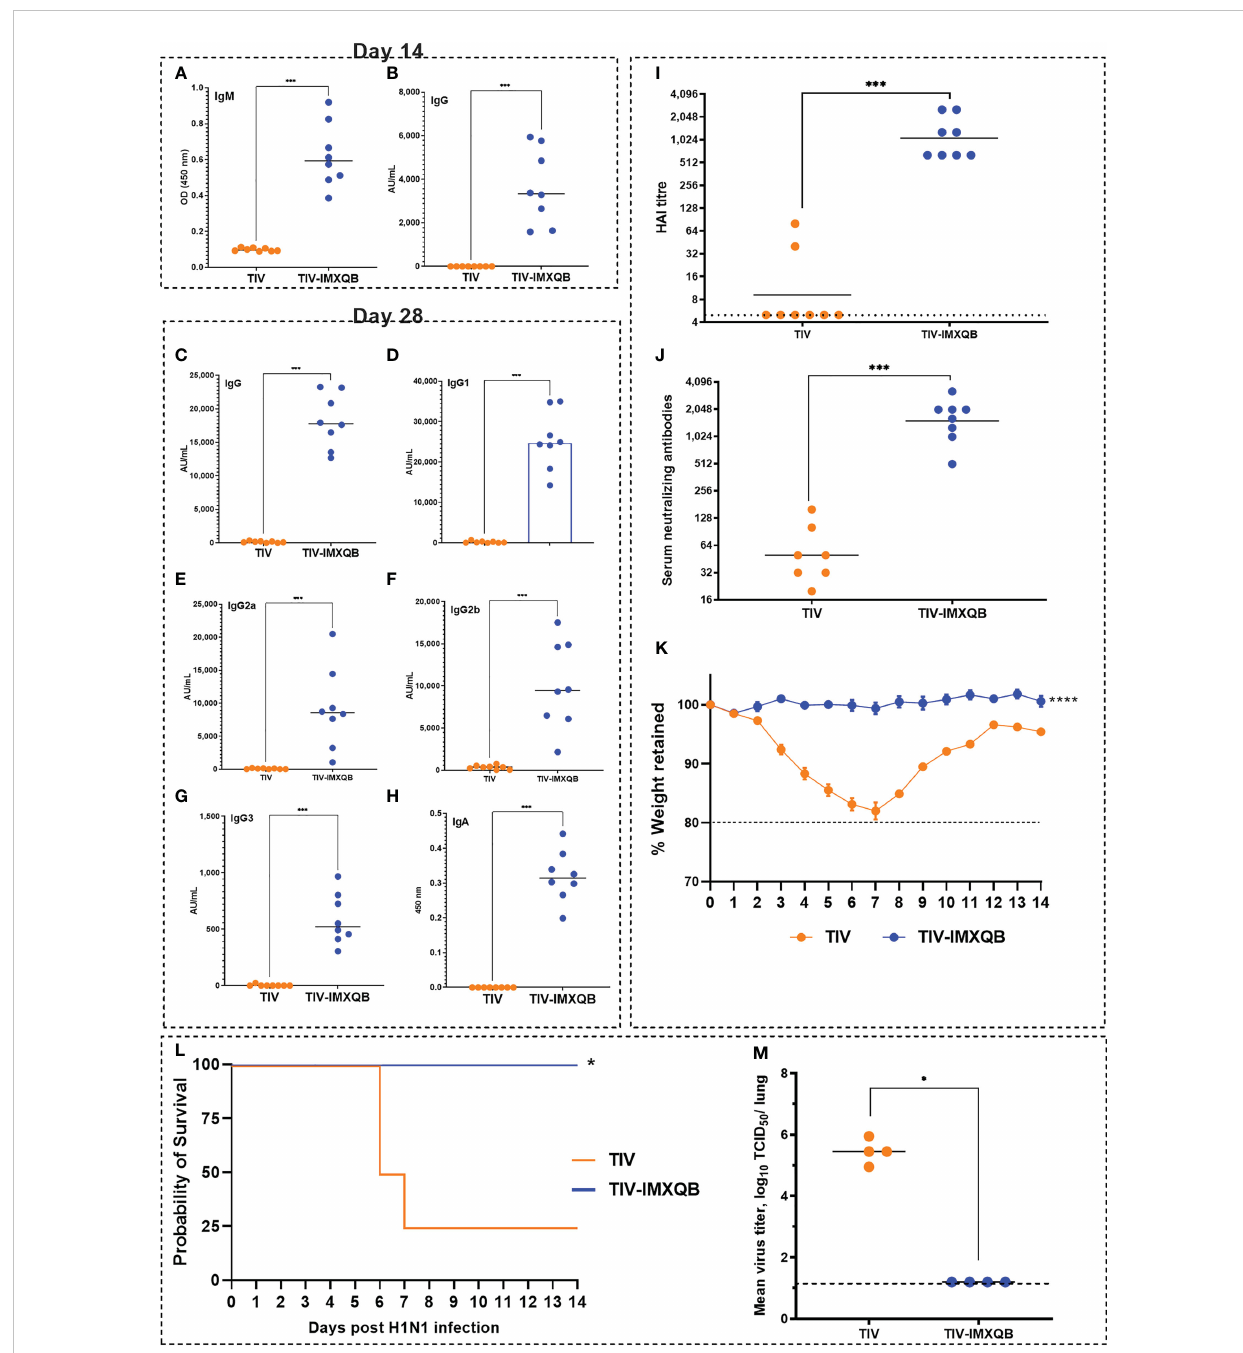
FIGURE 6 Intranasal delivery of TIV-IMXQB elicited a robust antibody response and promote protection against A/Uruguay/897/2018 (H1N1)pdm09-like virus challenge. Female BALB/c mice were vaccinated intranasally on day 0 (priming) and 14 (booster) with either trivalent in fl uenza vaccine (TIV) alone (commercial vaccine) or TIV-IMXQB and antibody levels were measured in sera. Anti-TIV IgM (A) and IgG (B) titers 2 weeks post-priming (day 14) were measured. Total anti-TIV IgG (C) , IgG1 (D) , IgG2a (E) , IgG2b (F) , IgG3 (G) , and IgA (H) were determined 2 weeks after the second immunization (day 28). The median value is indicated by a line, and the dots indicate individual values. Anti-in fl uenza virus antibody titers in serum samples were measured by hemagglutination inhibition (HAI) (I) or by microneutralization (MN) (J) assays. The geometric mean value is indicated by a line, and the dots indicate individual values. Thirty days after the priming all animals in each group (N=8/group) were intranasally challenged with 1 × 10 6 tissue culture infectious dose (TCID) 50 /50µL of A/Uruguay/897/2018 (H1N1)pdm09-like virus. Four animals per group were monitored for weight loss (K) (represented by mean and error) and mortality (L) . Viral titers in the lungs were determined on day 5 post challenge (N=4/group) (M) . The median value is indicated by a line, and the dots indicate individual values. Statistical analyses were performed using the nonparametric Kruskal – Wallis test with uncorrected Dunn ’ s post-test for multiple comparisons. Probability of survival as determined by Log-rank (Mantel-Cox) test compared to TIV alone. (A-K, M) median values are indicated by horizontal lines and dots indicate individual values for each animal. The dotted horizontal line in Figure (M) represents the lower limit of detection. Signi fi cant differences are indicated: *( P < 0.05 ), ***( P < 0.001 ) and ****(P < 0.0001) as determined by Log-rank (Mantel-Cox) test compared to TIV